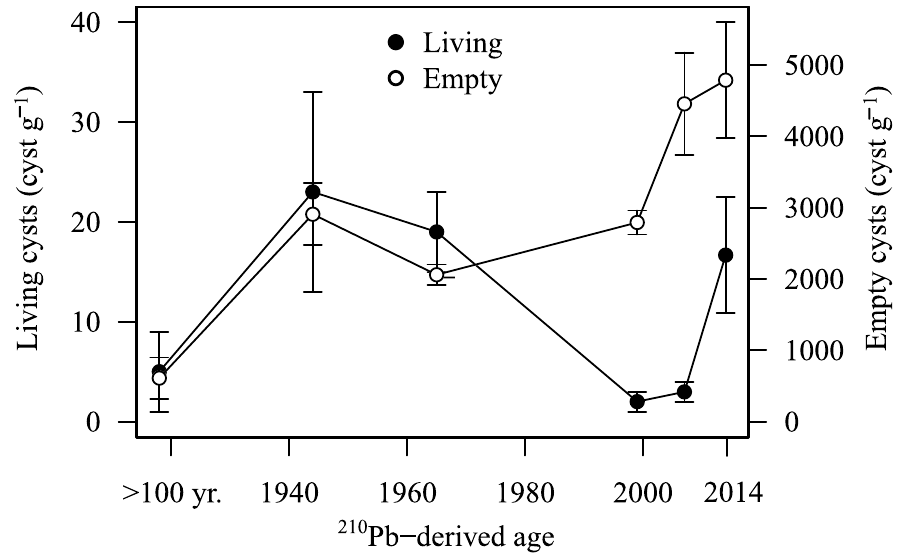
Figure 4. The abundance of living and empty cysts of Pyrodinium bahamense in the San José core (San José Lagoon, SW Gulf of California).